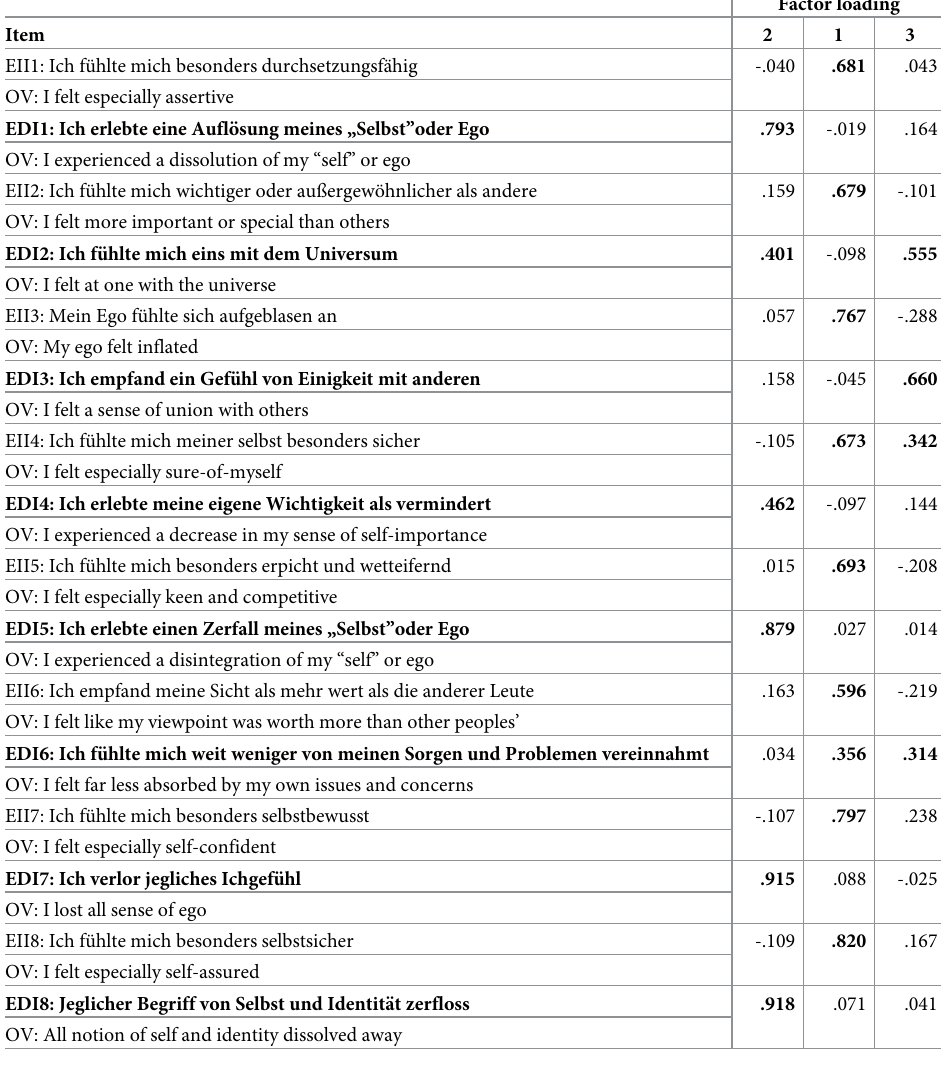
OV: All notion of self and identity dissolved away Extraction method: principal axis factoring; rotation method: promax with Kaiser normalization. Factor loadings (taken from pattern matrix) > .30 are in bold. Factor 1 was interpreted as ego-inflation, factor 2 as ego-dissolution and factor 3 did not allow for any definite qualitative